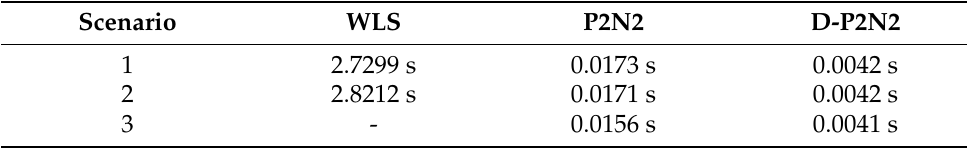
Table 2. The estimation time of each time